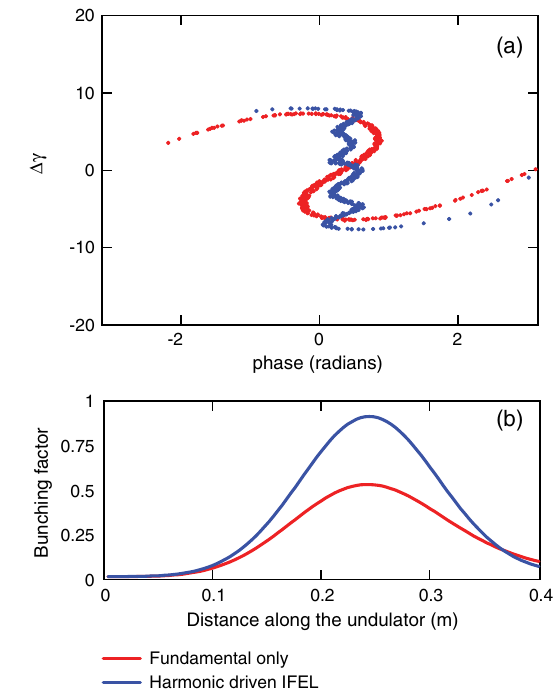
FIG. 7. Longitudinal phase space and longitudinal distribution of a typical and a harmonic